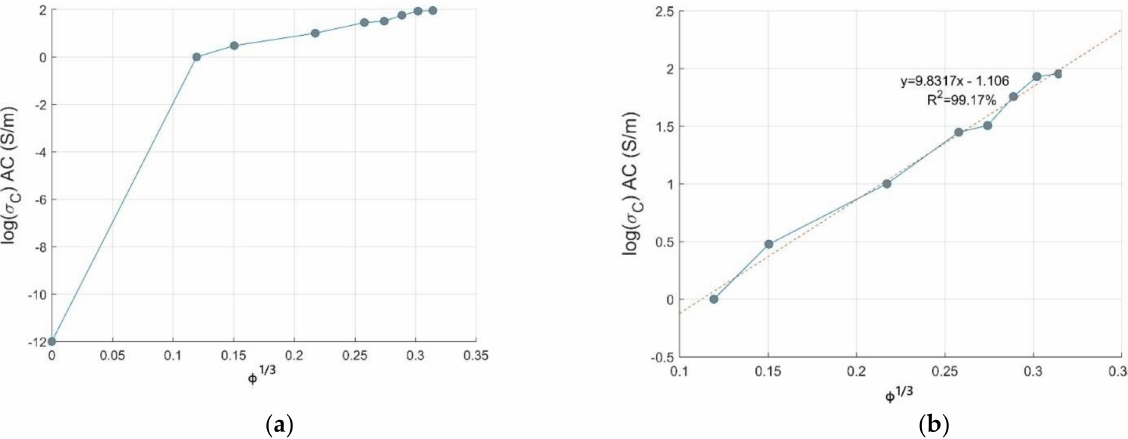
Figure 3. Theoretical conductivity against volume fraction of CNTs based on Voet model for PC-CNT conductive composites. ( a ) low volume fraction, ( b ) remarkable